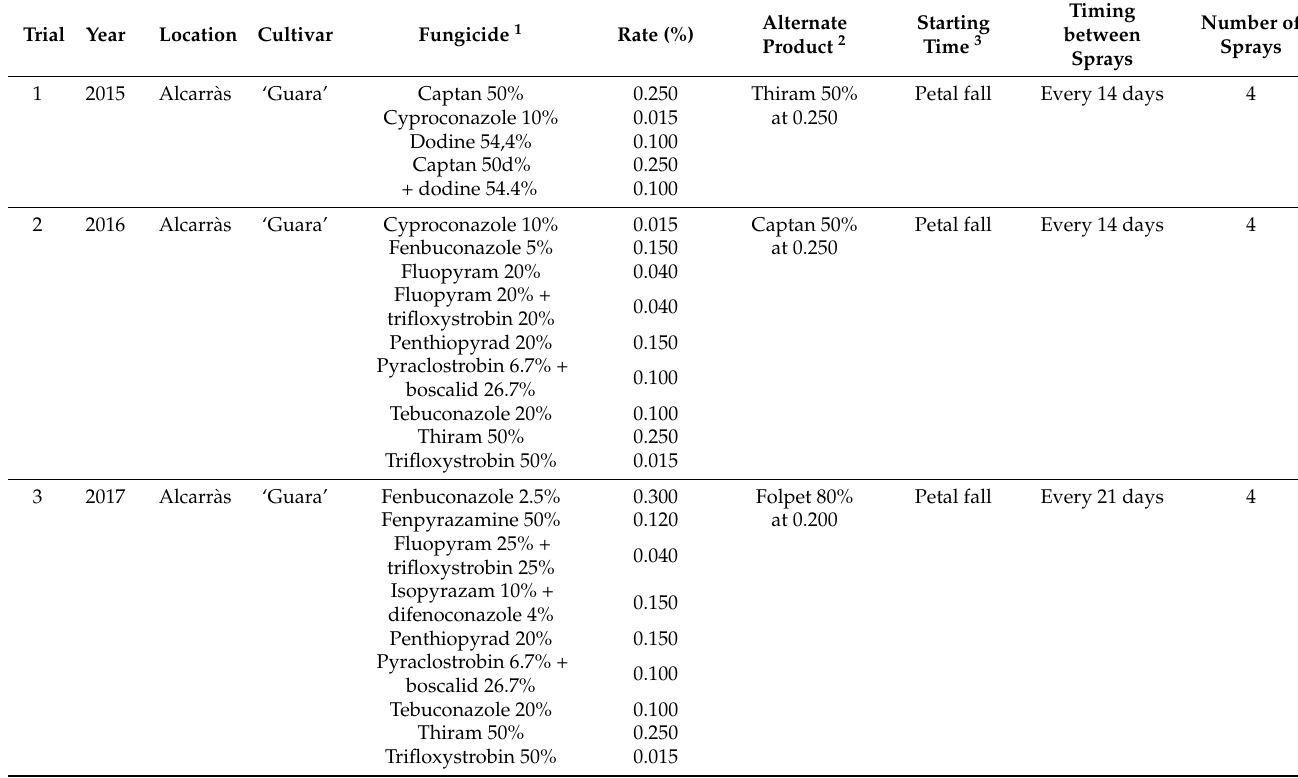
Table 2. Trials of fungicides against the almond red leaf blotch conducted in 2015–2017 in the Lleida region, Spain, using alternating products.